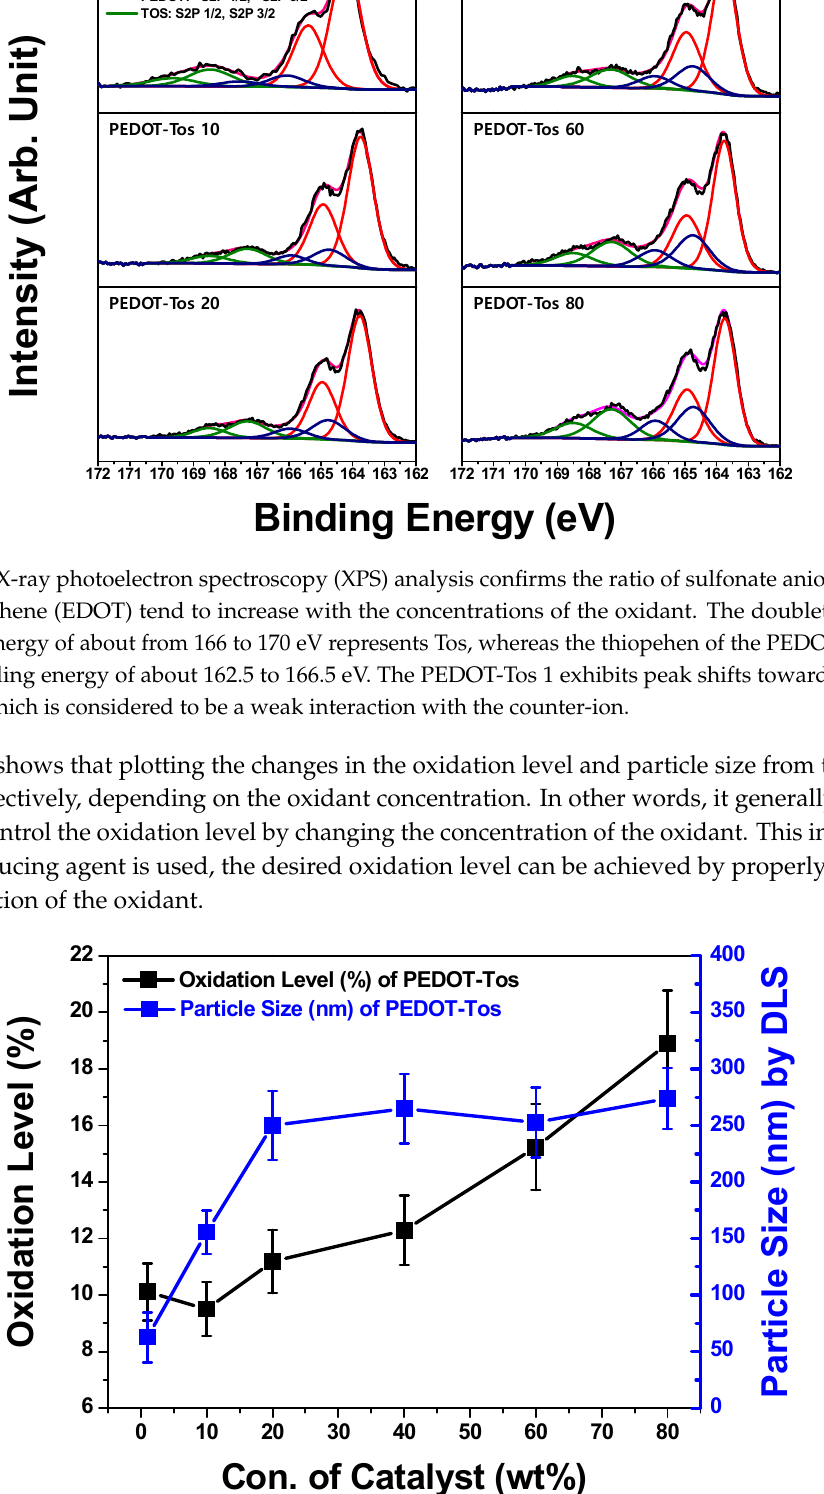
Figure 6. The oxidation level (%) by XPS analysis and the particle size (nm) by DLS analysis are plotted with the concentrations of the oxidants. Both properties tend to increase with loading the oxidant.